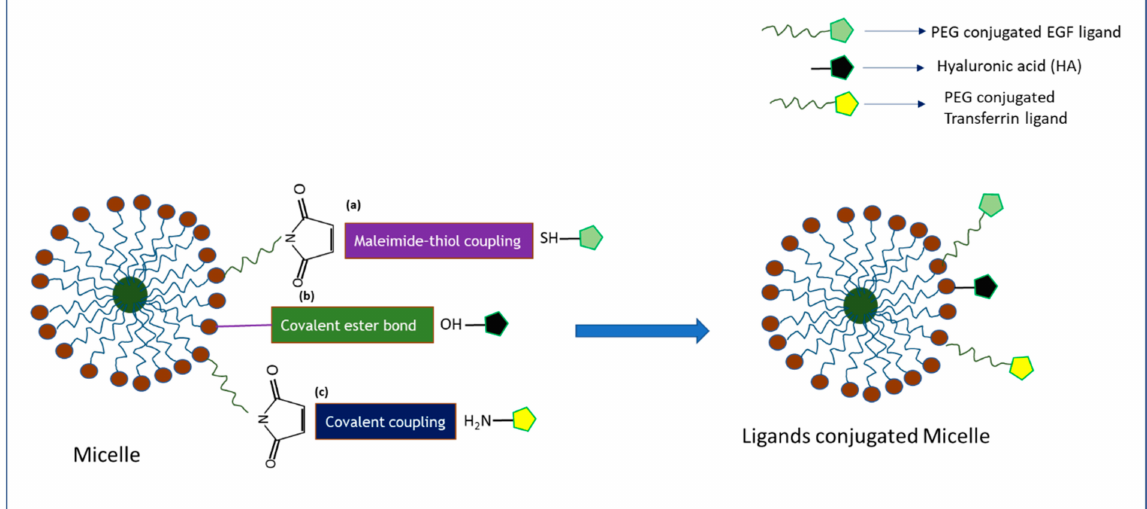
Figure 6. Strategies in conjugation ligands with polymeric micelles: schematic representation of the reactions between the functional groups of polymeric micelles and multiple ligands via (a) maleimide-thiol coupling, (b) covalent ester bond, and (c) covalent